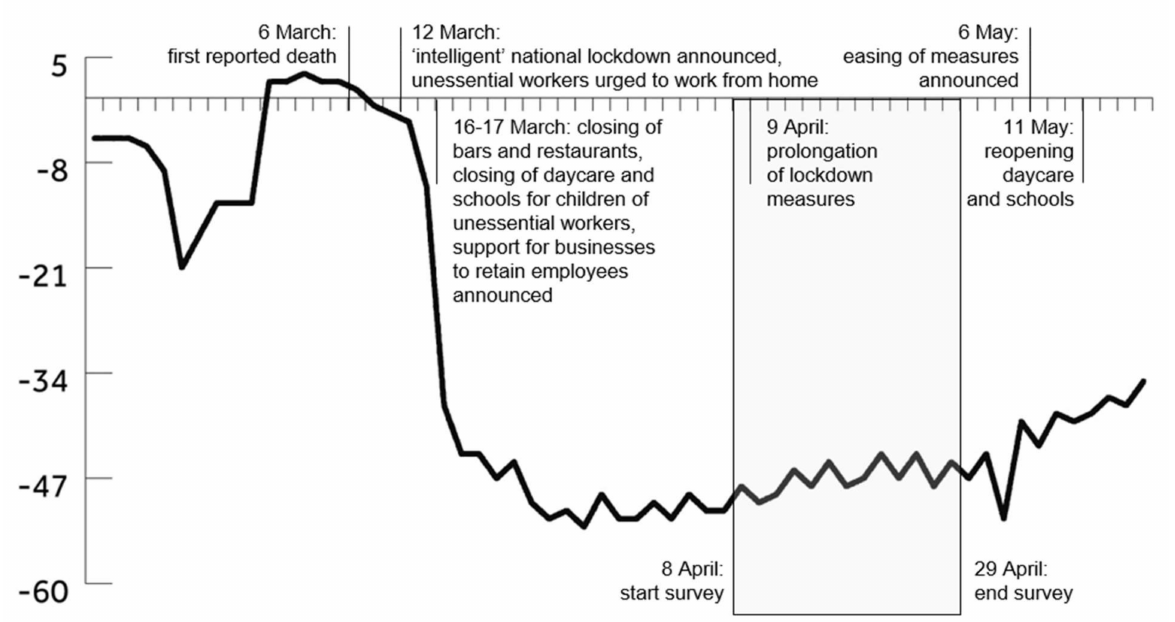
Figure 1. Timeline of the first lockdown in the Netherlands. The vertical axis displays the estimated percentage of decline in crowding of workplaces on workdays compared to normal according to Google Community Mobility Reports based on